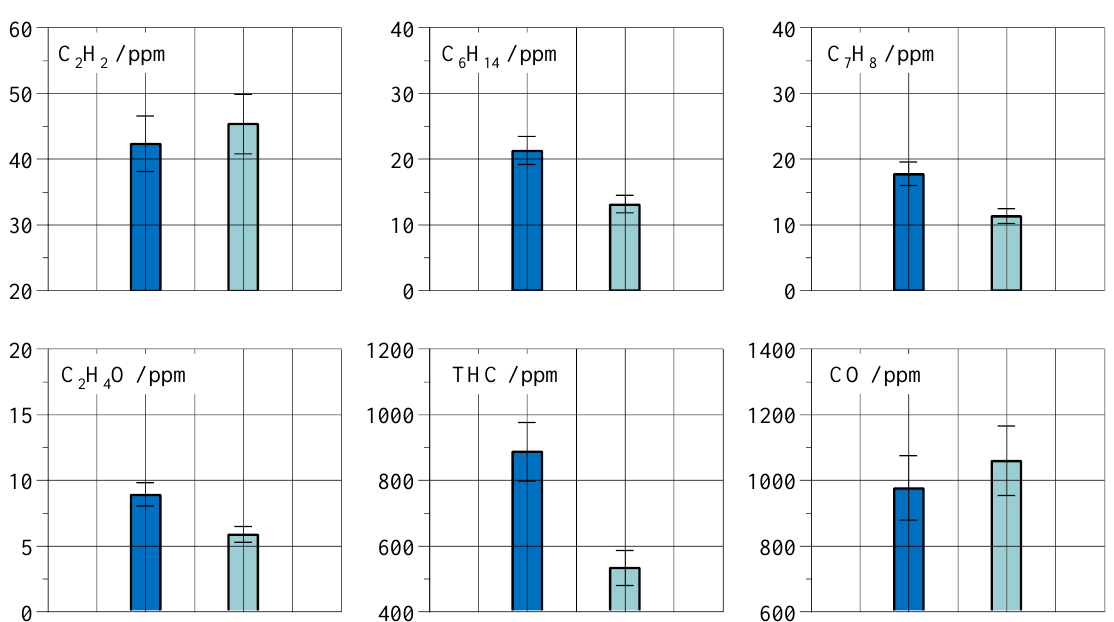
Figure 7. Measured species of near-wall gas sample of the GSV at n = 800 1/min and IMEP = 3 bar.